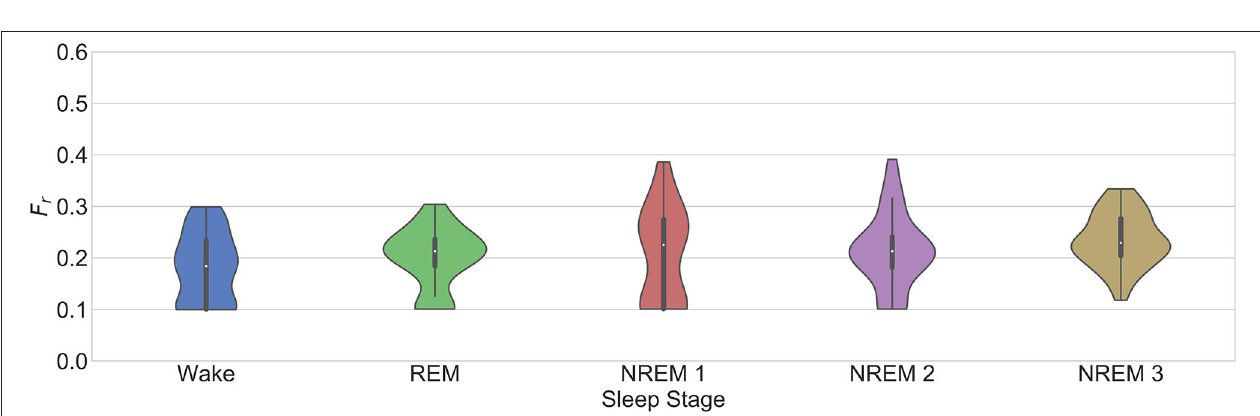
FIGURE 7 | F r for the selection of the model order in the third dataset as described in section